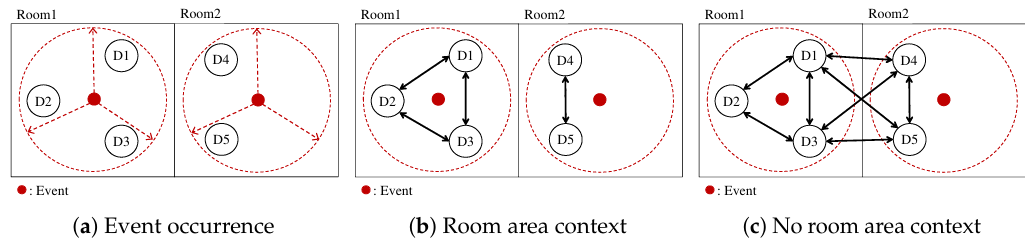
Figure 4. Communication in Room Area Context: each circle denotes the confinement of the ephemeral group members in the room area context, but others in the next room might have signals due to the penetrative nature of local connectivity. ( b , c ) The cases of having the room area context and not, respectively, for the two events occurred simultaneously, as shown in ( a